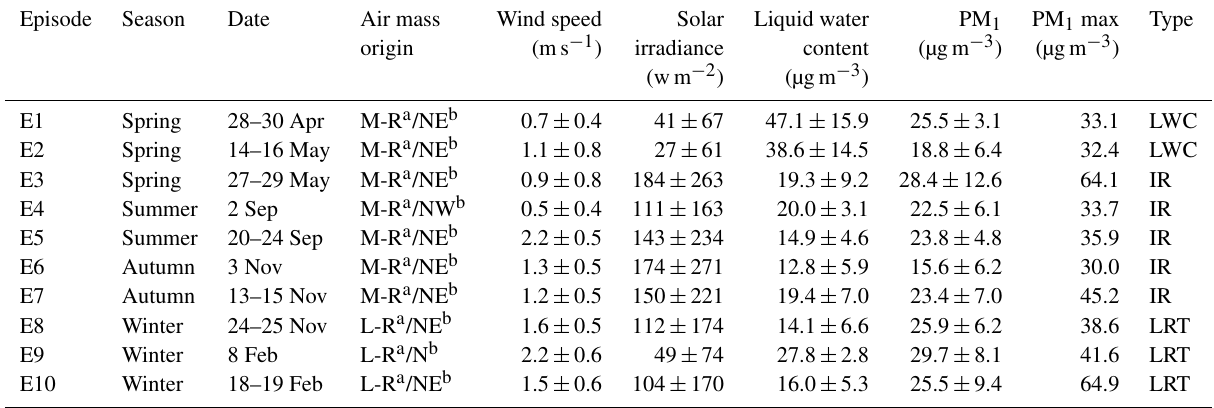
Table 1. Synopsis of meteorological conditions of high-PM episodes. Episode